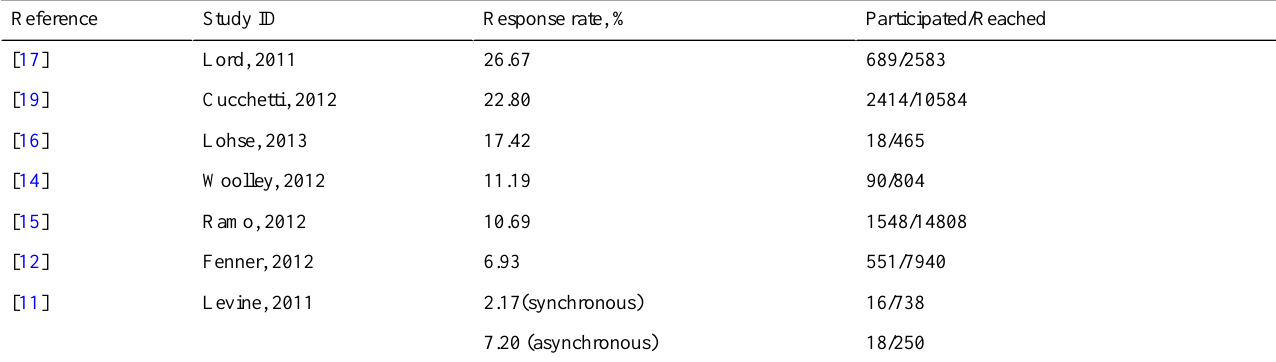
Table 2. Reported response rates of included studies.